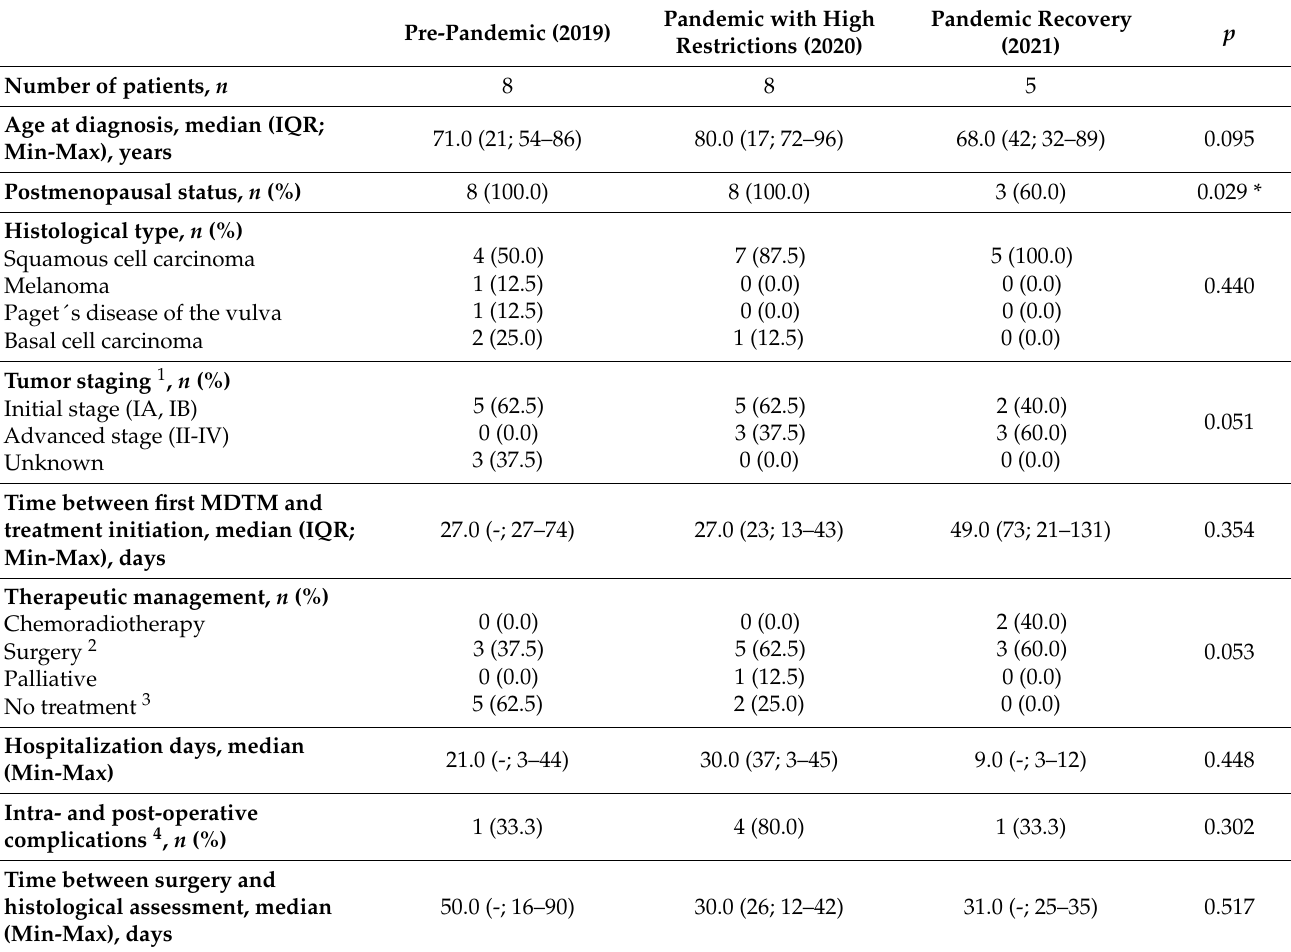
Table 4. Epidemiological, clinical and pathological patterns of patients diagnosed with vaginal and vulvar cancer ( n =